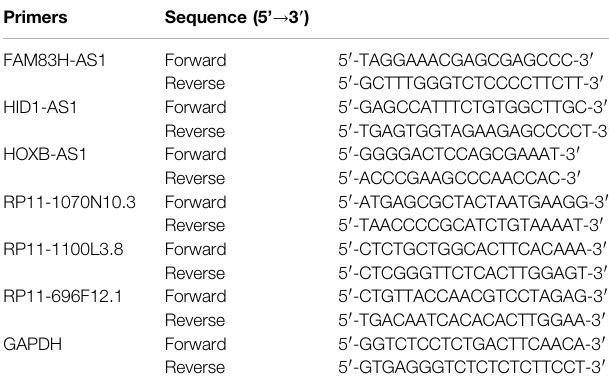
TABLE 1 | Primers used in quantitative polymerase chain